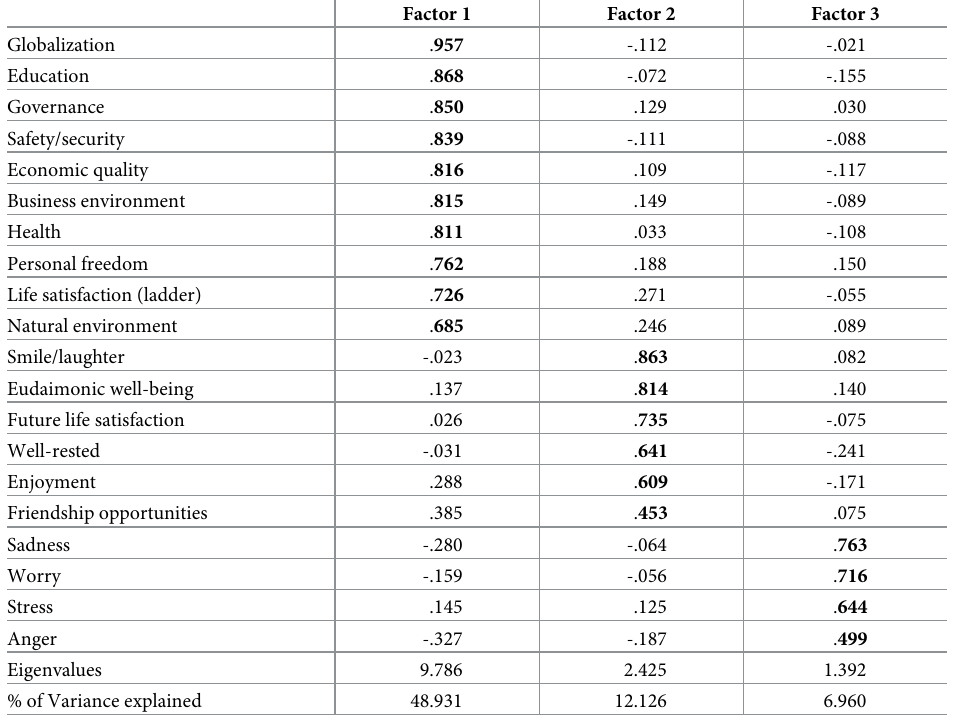
Table 2. Results of exploratory factor analysis (2015–2017, N = 138). Factor 1 Factor 2 Factor